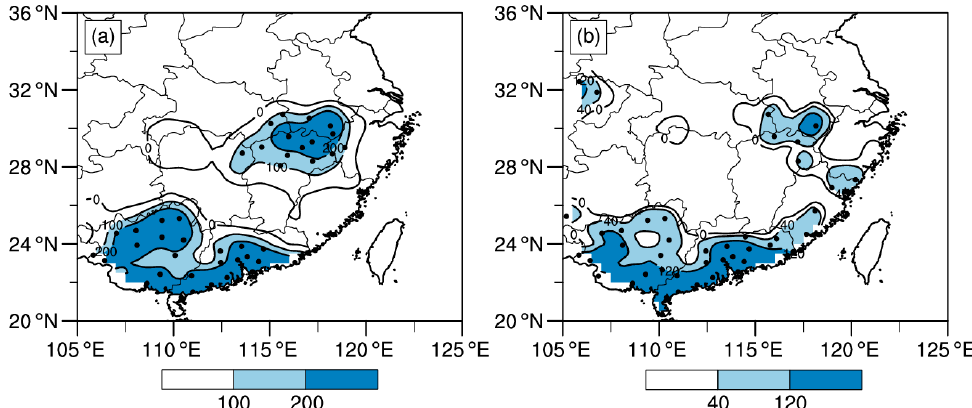
Figure 3. The spatial deviation fields of annual mean total summer precipitation after subtracting the domain means in southern China for 10 flood years ( a ) and 9 drought years ( b ). The black dots indicate the stations where deviation values ≥ 100 (40) mm in flood (drought) years (unit: mm).